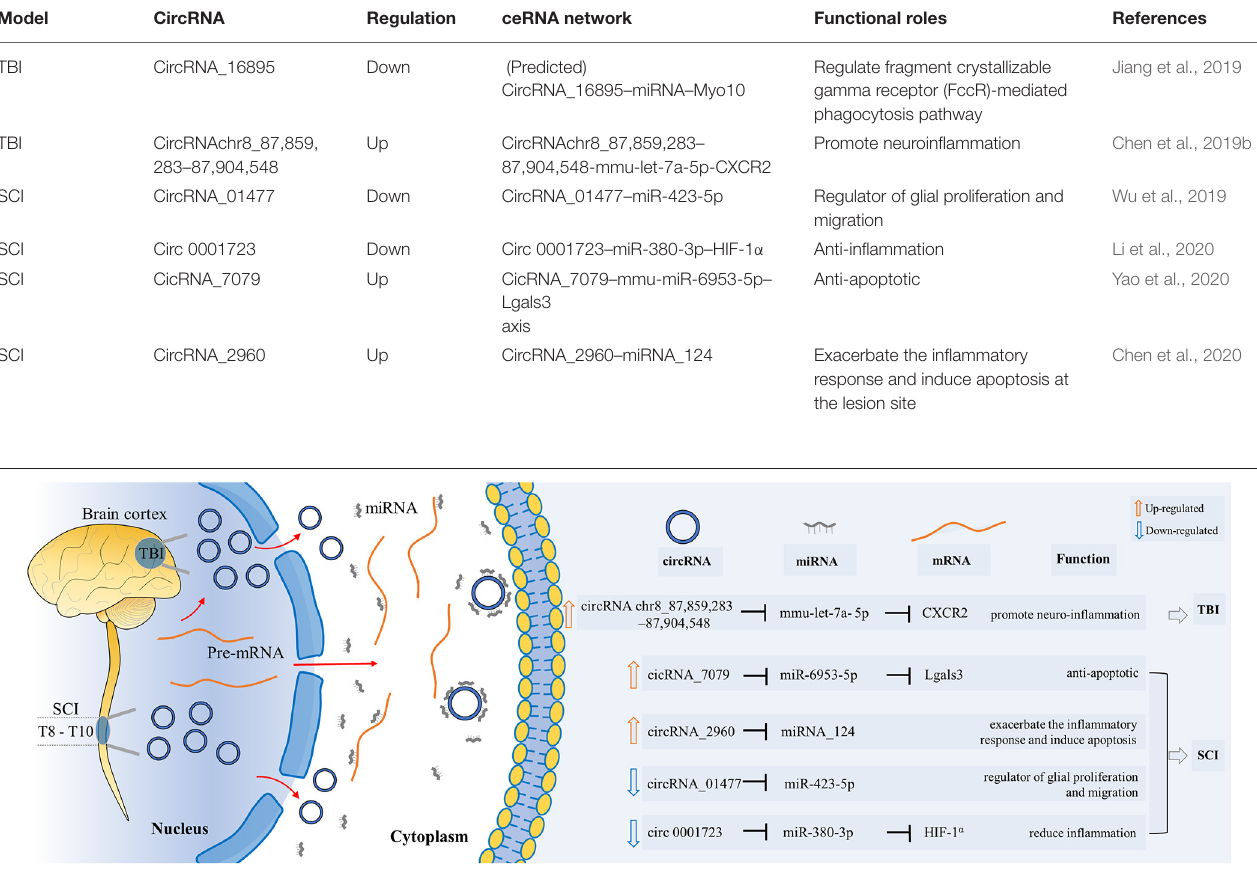
FIGURE 2 | Functional roles of specific circRNAs in CNS post-traumatic injury. CircRNAs play their roles as miRNA sponges through the circRNA–miRNA–mRNA interaction networks. They influenced the biological processes of proliferation, inflammation, apoptosis,